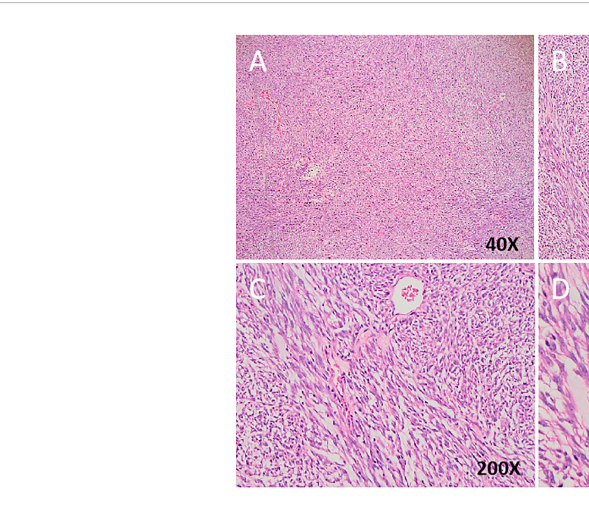
FIGURE 2 (A – D) Spindle tumor cells are arranged in fascicles with palisading pattern. Hematoxylin and eosin counterstain in different magni fi